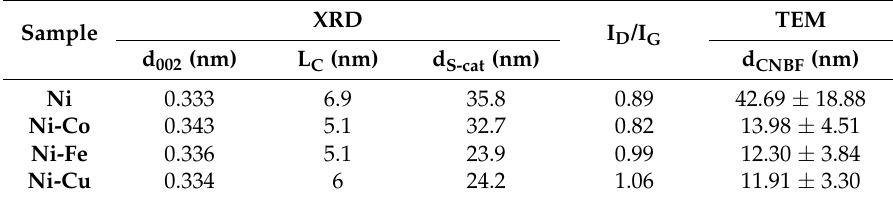
Table 5. Interplanar distance, carbon crystal domain size, catalyst crystal domain size, I D /I G ratio, and carbon bio-nanofilaments diameter of the carbonous materials obtained after the reaction.